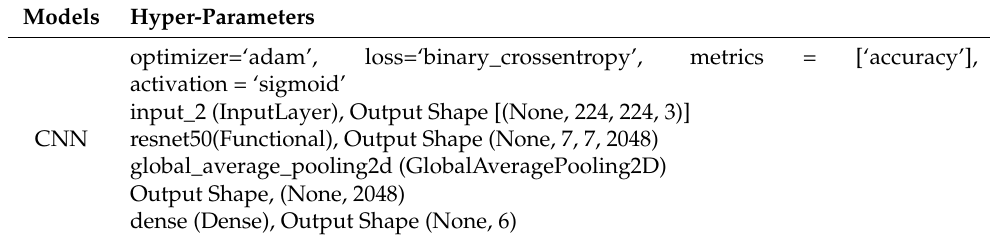
Figure 6. Explosion location of Beirut Port. Table 2. Structure of the CNN